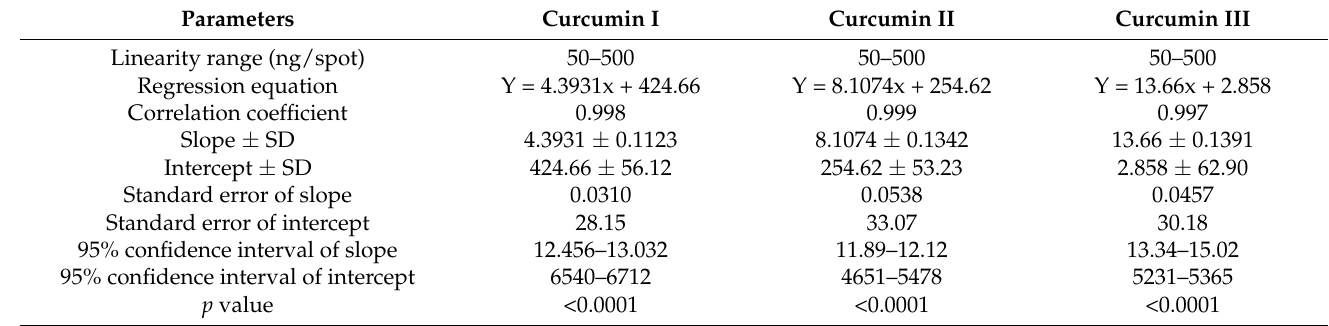
Table 1. Linear regression data for the calibration curve of curcumins I–III ( n = 6).